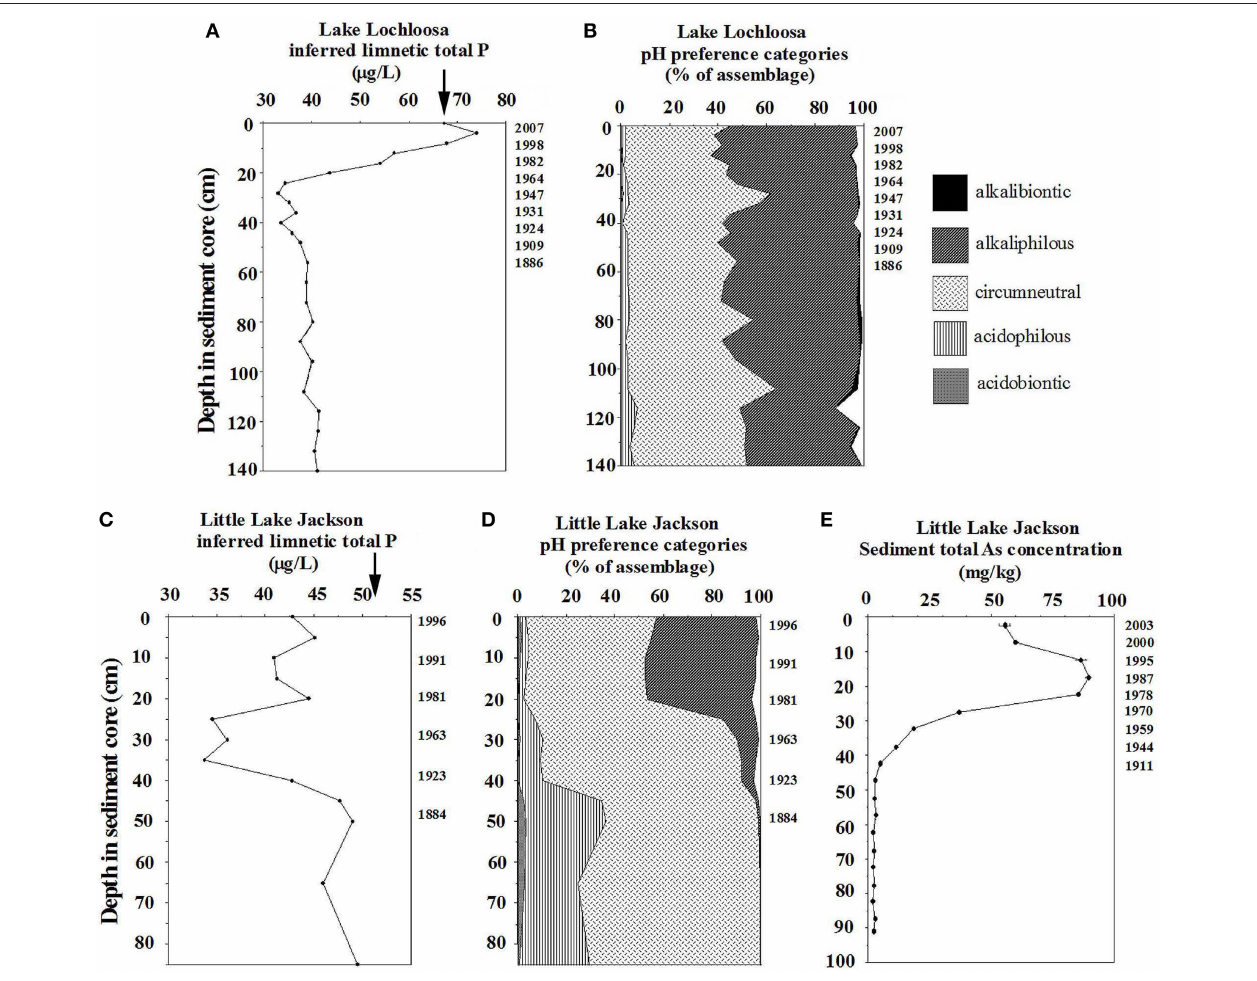
FIGURE 1 | Diatom-based inferred limnetic total P values for Lakes Lochloosa and Little Jackson, with summary pH autecological preference information, and sedimented arsenic concentrations in Little Lake Jackson. Summary pH autecological information was calculated as in Whitmore et al. (1996). Arrows on total P panels indicate means of modern measured water quality. (A) Inferred limnetic total P for Lake Lochloosa (modified from Kenney et al., 2014). (B) Summary pH preference data for diatoms in Lake Lochloosa. (C) Inferred limnetic total P for Little Lake Jackson. (D) Summary pH preference data for diatoms in Little Jackson (updated from Whitmore et al., 2006). (E) Net sedimented total As concentrations from Little Lake Jackson (modified from Whitmore et al.,